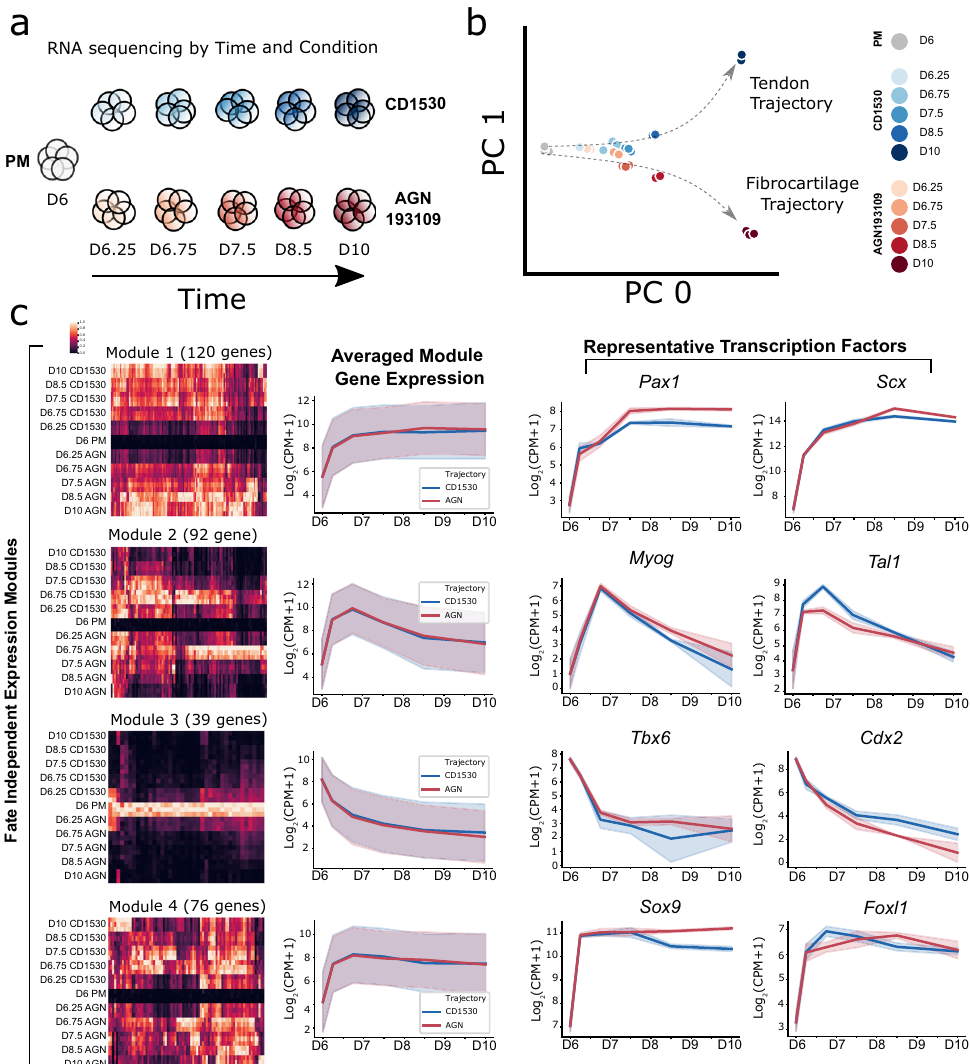
Fig. 4 Transcriptional pro fi ling and trajectory analysis by RNA sequencing reveal transcription factor modules associated with differentiation. a Schematic for RNA-seq of CD1530 (blue) and AGN 193109 (red) temporal trajectories starting from the common starting point of D6 PM. Samples were collected at indicated timepoints and conditions for RNA-seq. b PCA of tendon and fi brocartilage trajectories. c Fate-independent gene modules represented as column-normalized heatmaps, averaged module gene expression line plots, and representative transcription factors. ( n = 3 independent samples). Standard deviation is represented by shaded